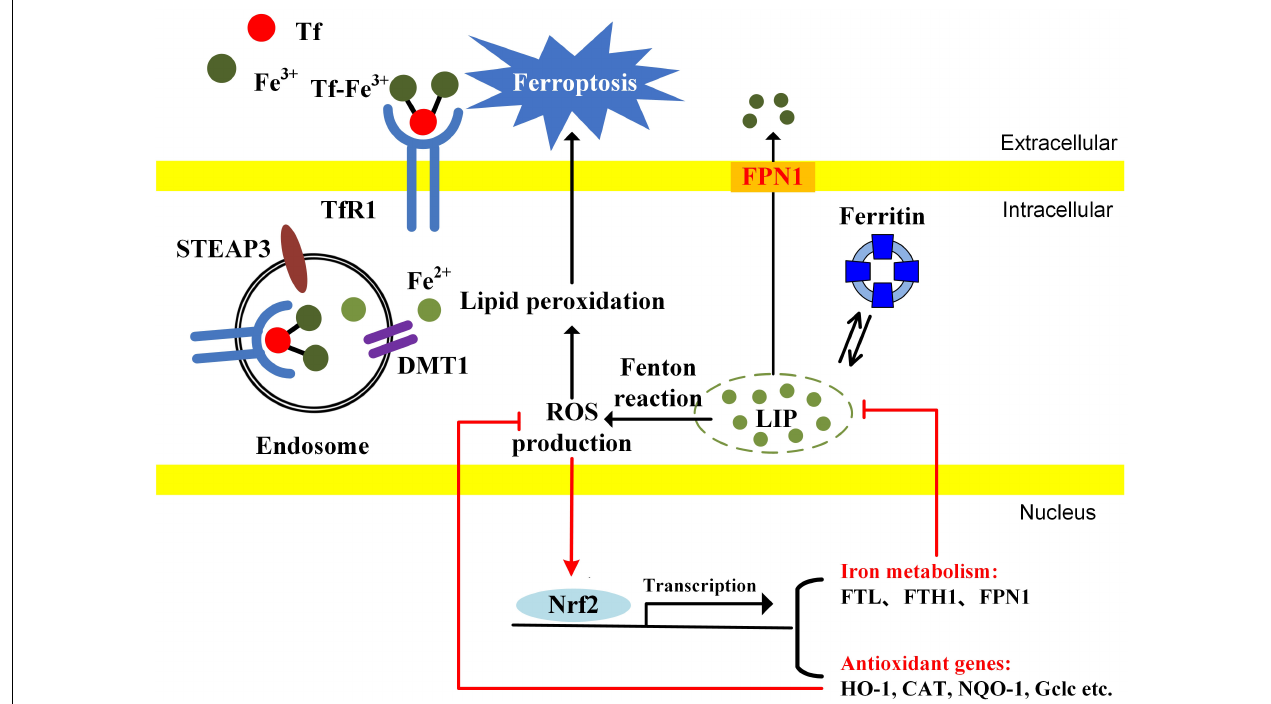
FIGURE 3 | The possible mechanisms of Nrf2 modulating iron metabolism and redox balance in cancer cells. The cancer cells have an enhanced iron uptake compared with normal cells. The LIP, a free cellular iron pool, generates ROS through Fenton reaction, causing the activation of Nrf2. Nrf2 translocates into the nucleus and promotes the transcription of genes associated with antioxidant enzymes and iron metabolism. Ferritin and FPN1 reduce the cellular free iron. Antioxidant enzymes reduce the ROS accumulation. Since cellular free iron and iron-dependent lipid peroxidation are essential for ferroptosis induction, Nrf2 inhibition probably contributes to ferroptosis by simultaneously enhancing LIP and oxidative